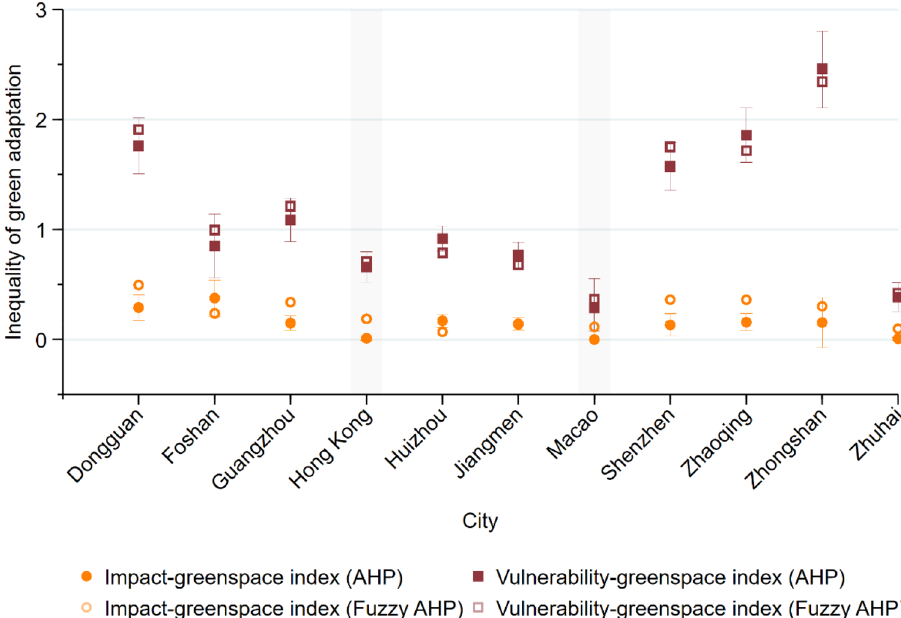
Figure 2. City-level spatial inequalities of green adaptation on climate impacts and vulnerability. Illustrated by authors using Stata statistical software (StataCorp LLC. Stata/MP 16, https:// www. stata. com).